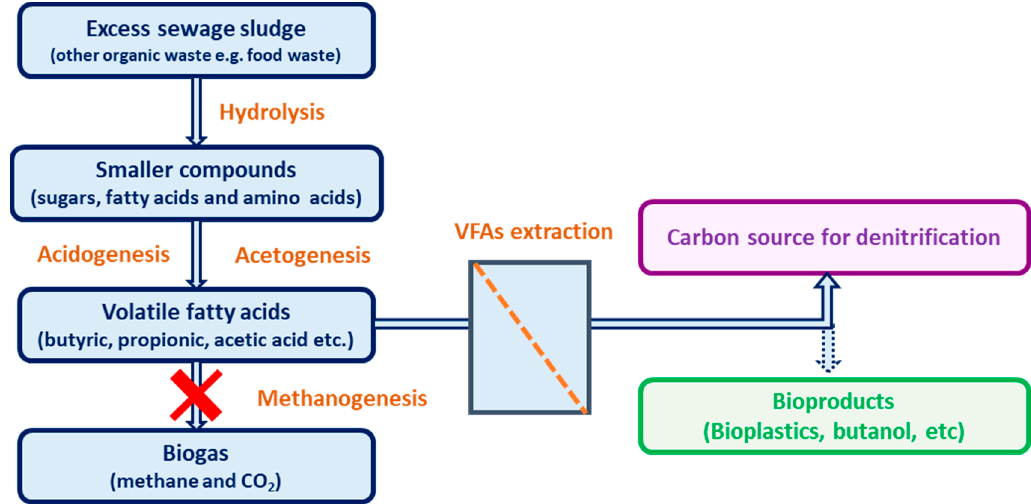
Figure 2. Anaerobic digestion of excess sludge and other organic wastes for the production of volatile fatty acids (VFAs) instead of biogas.